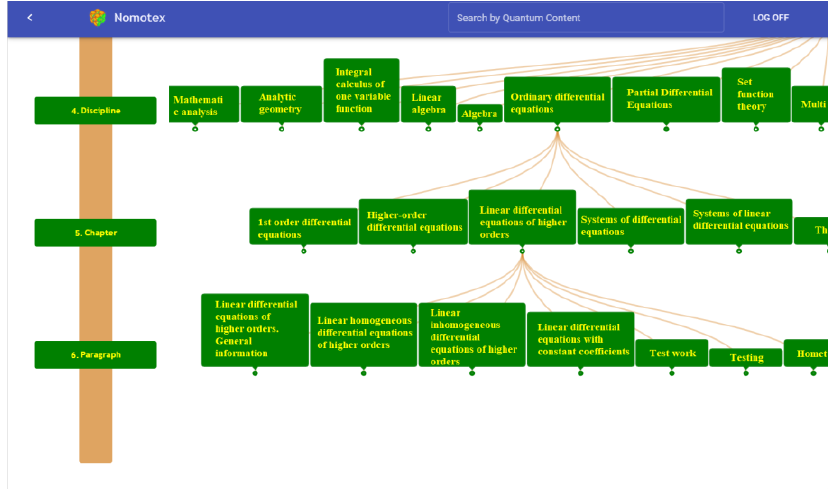
Fig. 1. Neural network knowledge structure